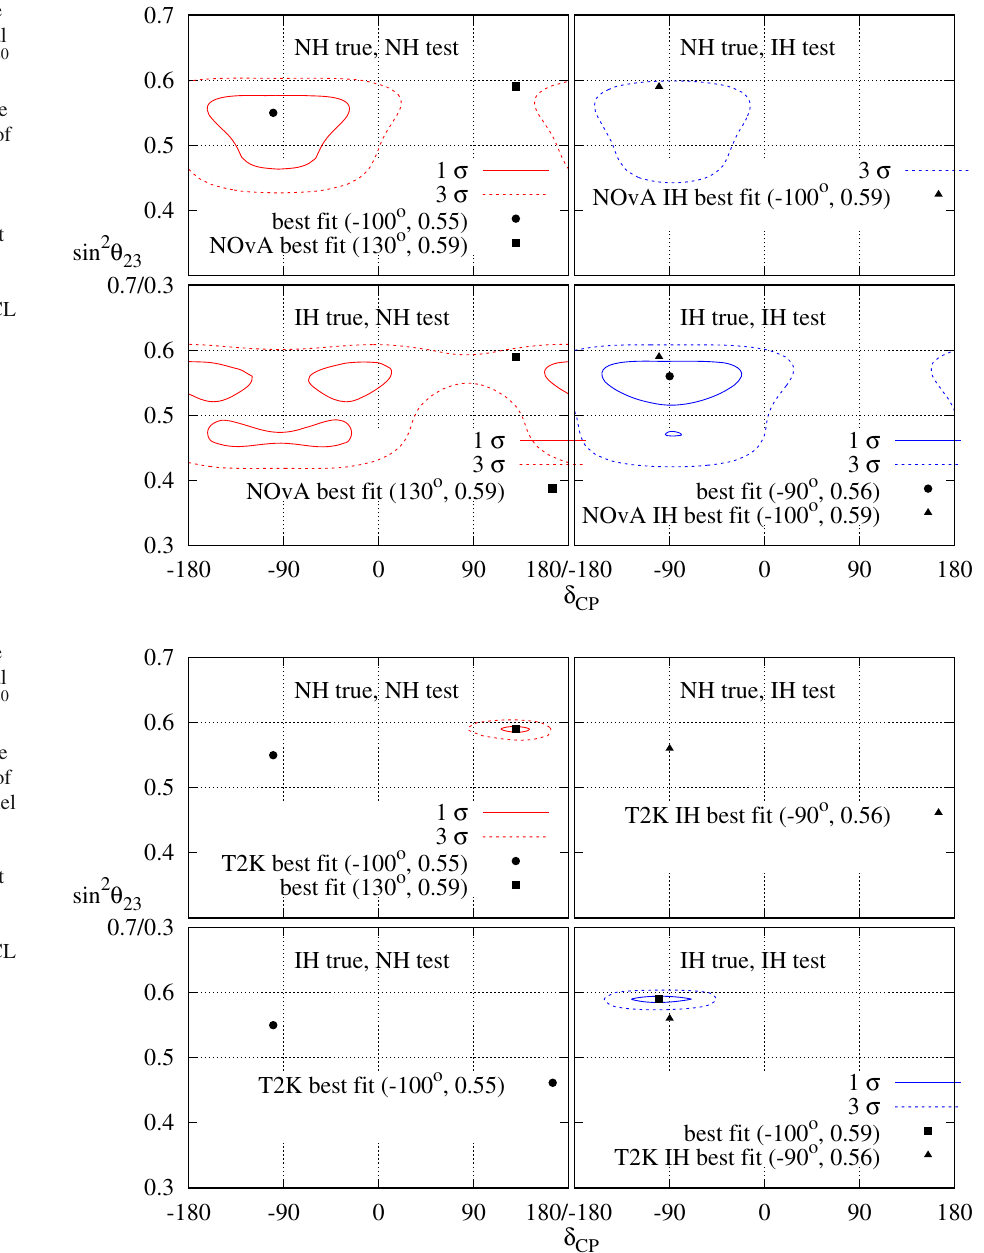
Fig. 12 Allowed region in the sin 2 θ 23 − δ CP plane after equal ν and ¯ ν run of total 73 . 5 × 10 20 POT each for DUNE. True oscillation parameter values are fixed at current best fit values of NO ν A . The upper (lower) panel shows the allowed regions for NH (IH) as true hierarchy. The left (right) panel represents test hierarchy NH (IH). The solid (dashed) lines indicate the allowed regions for 1 σ (3 σ )